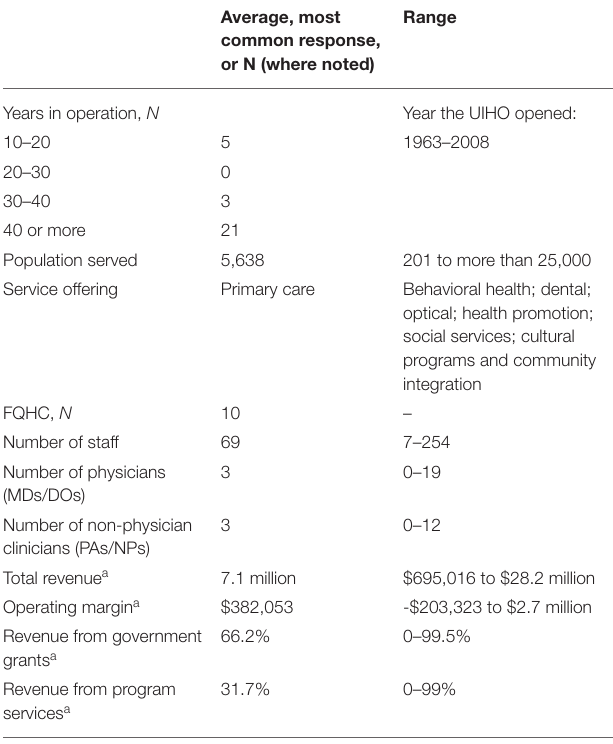
TABLE 1 | Central features of Urban Indian Health